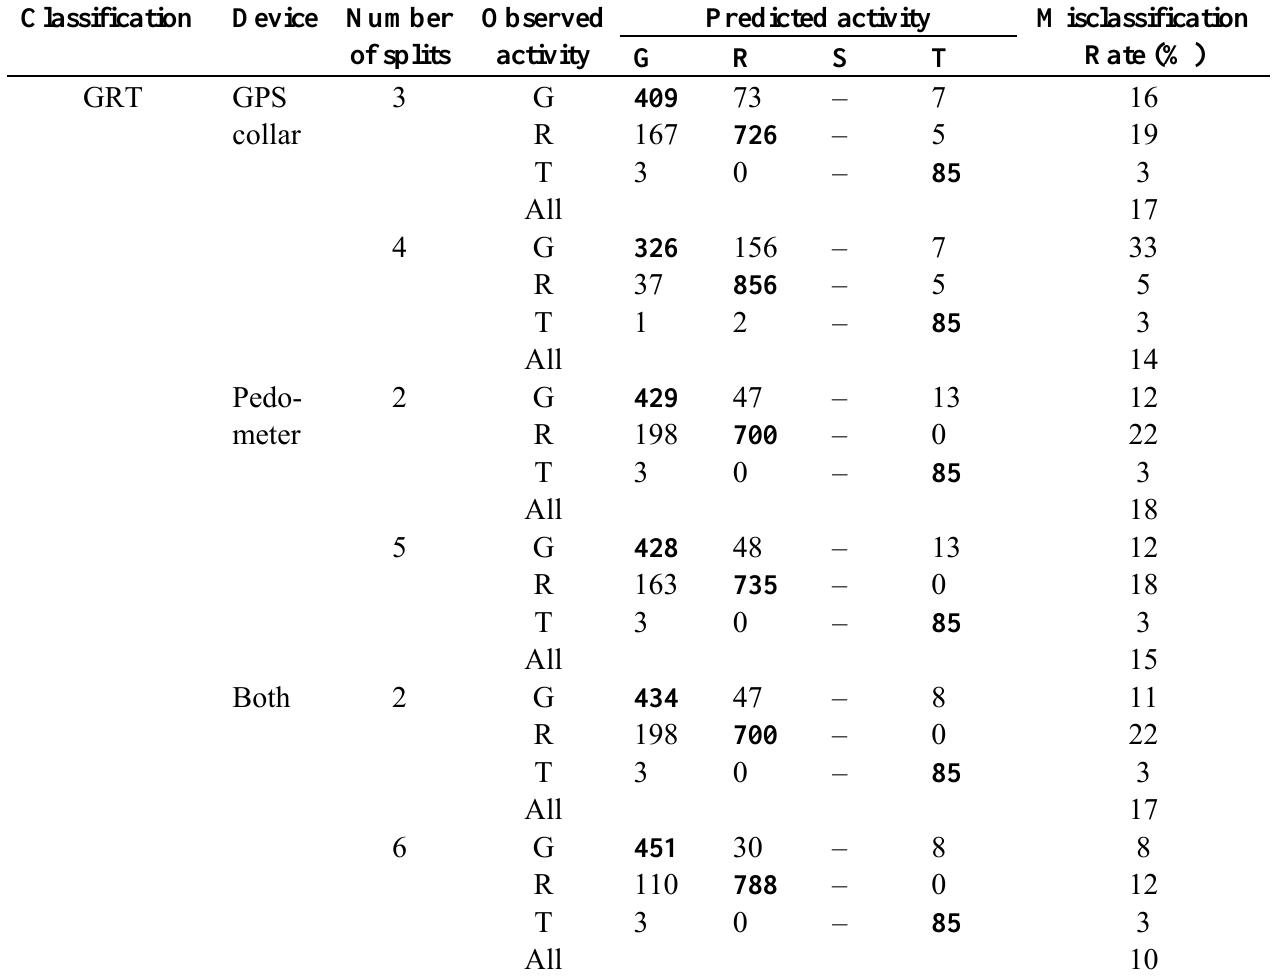
Table 2. Frequency of observed versus predicted activity and misclassification rates obtained in the inference of animal activity, classified as GRT and GLST, by partition (classification tree) analysis on the basis of data from the Lotek GPS collar only, the IceRobotics IceTag pedometer only, and both devices together. Elements on the upper-left to lower-right diagonal (bold) are correctly classified observations. Ideally, all observations should fall on this diagonal. G = Graze, R = Rest, T = Travel, L = Lie, S =